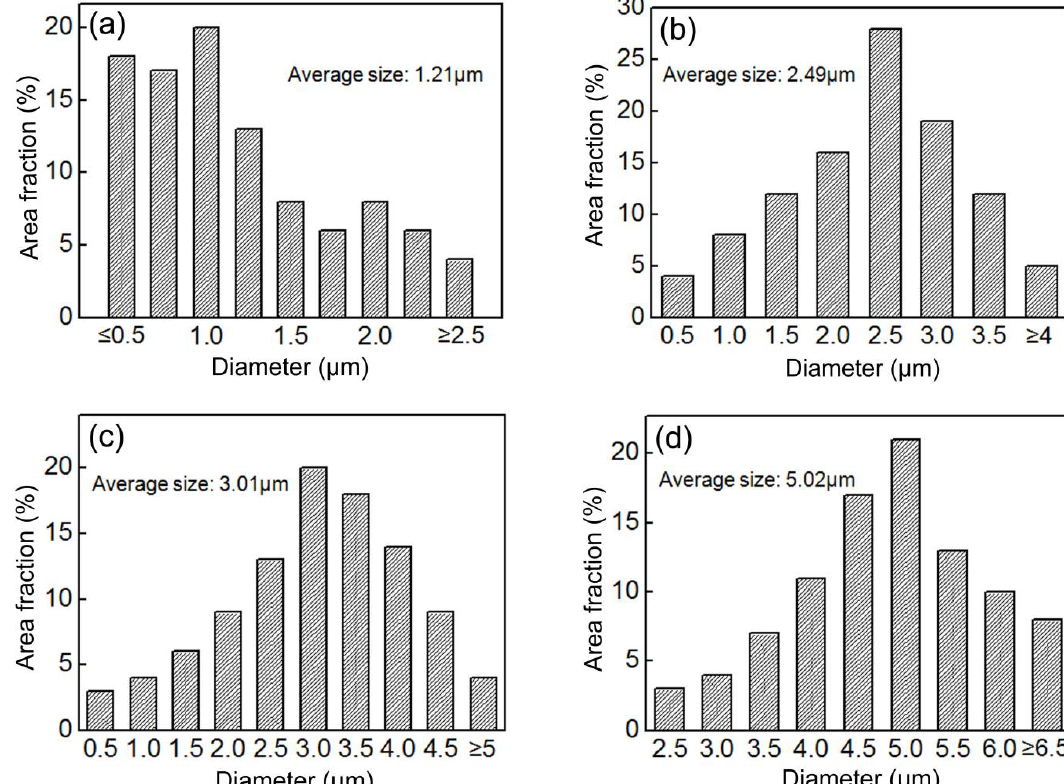
Figure 3. Size distribution of the blocky M-A constituents in the IC HAZ for different peak temperatures: ( a ) 760, ( b ) 765, ( c ) 770, and ( d ) 800 °C.